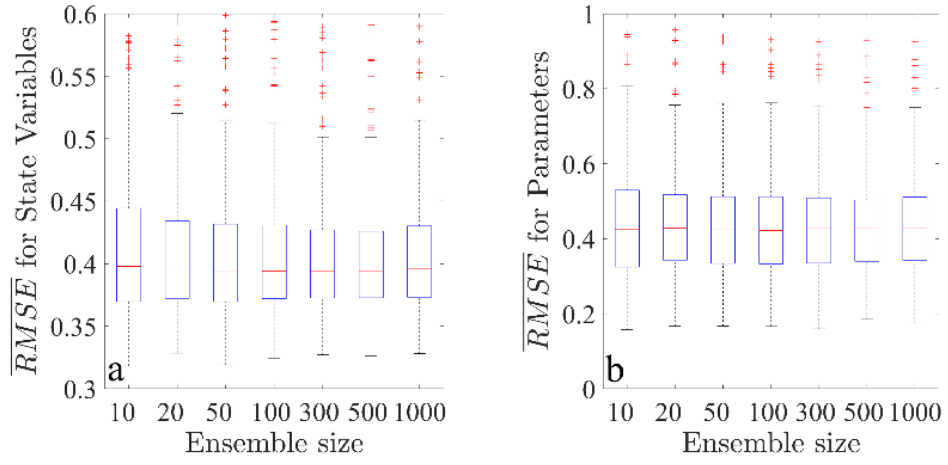
Figure 6. The effect of assimilation ensemble size on RMSE for ( a ) variables and ( b ) parameters. Note that the window length and observational period are fixed and are 72 and 12 time steps, respectively. The symbols of box plot are the same as those in Figure 4. The outliers are marked as red +.